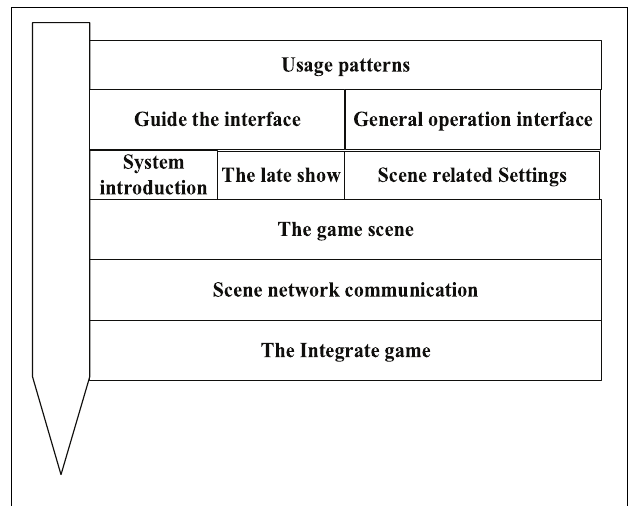
FIGURE 7 | Positioning flowchart. FIGURE 8 | Sand Table game system design